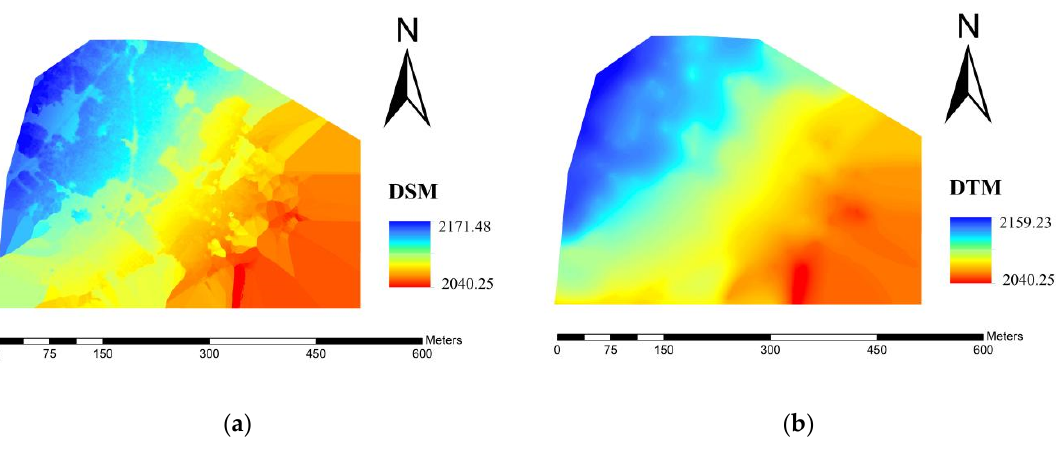
Figure 5. DSM ( a ) and DTM ( b ).